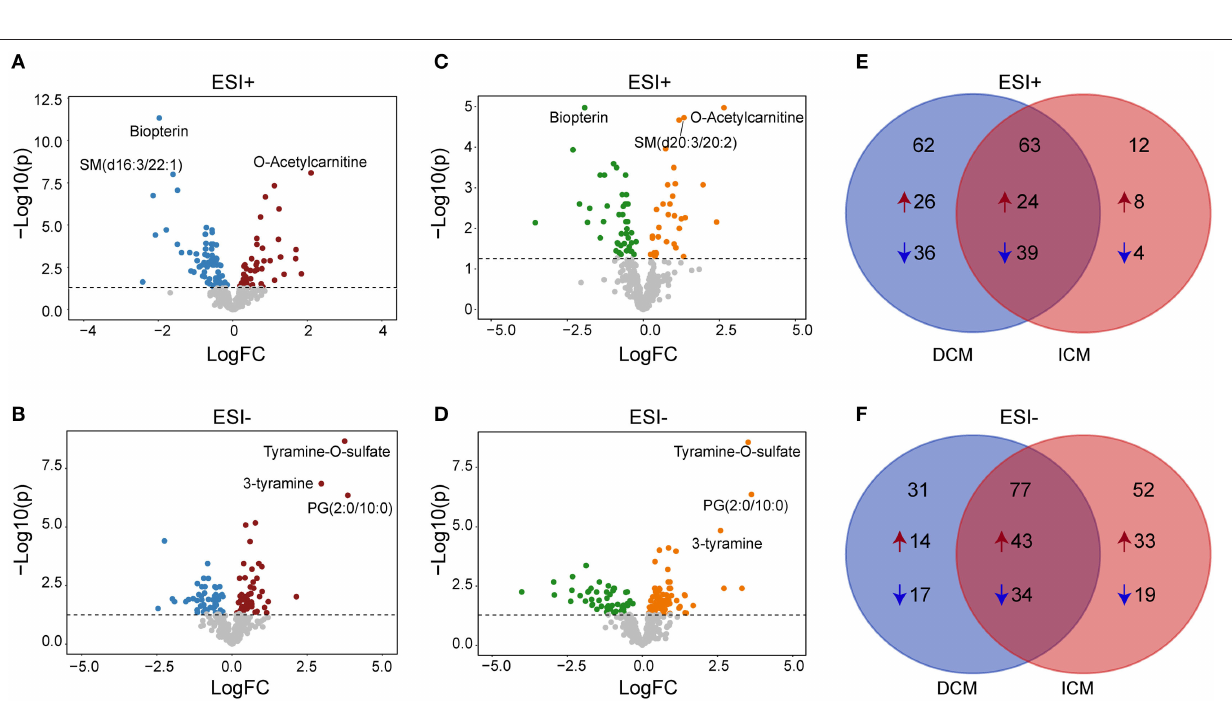
FIGURE 3 | Differential metabolites between patients with DCM, ICM, and healthy controls. Volcano plots for dysregulated endogenous metabolites between patients with DCM and healthy controls in positive ion mode (A) and negative ion mode (B) . Volcano plots for dysregulated endogenous metabolites between patients with ICM and healthy controls in positive ion mode (C) and negative ion mode (D) . Each plot represents a metabolite. The differentiating metabolites with adjusted P < 0.05 were highlighted in color. The venn diagram displayed the differential metabolites shared with DCM and ICM and the specific metabolites to be significant only in one comparison in in positive ion mode (E) and negative ion mode (F)